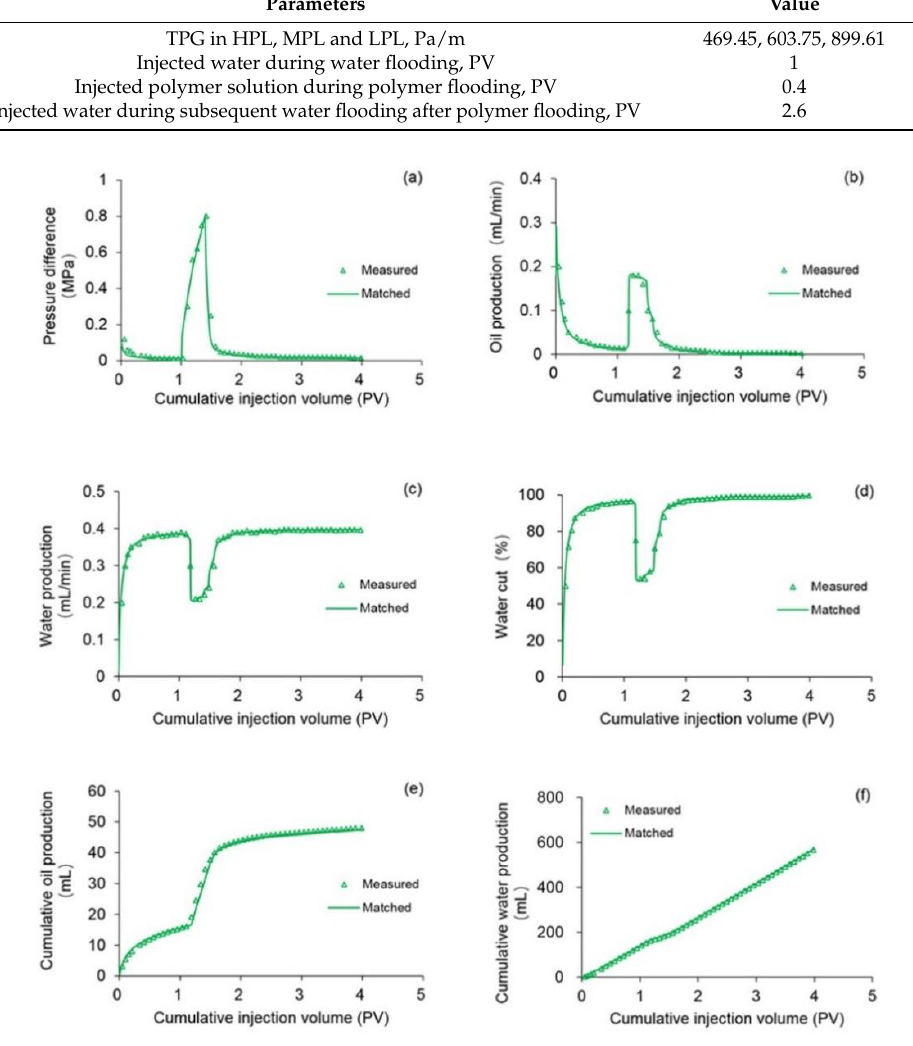
Figure 12. Comparison results of ( a ) pressure difference, ( b ) oil production, ( c ) water production, ( d ) water cut, ( e ) cumulative oil production and ( f ) cumulative water production of Case 2 simulated by the designed simulator and the TPF experiment.